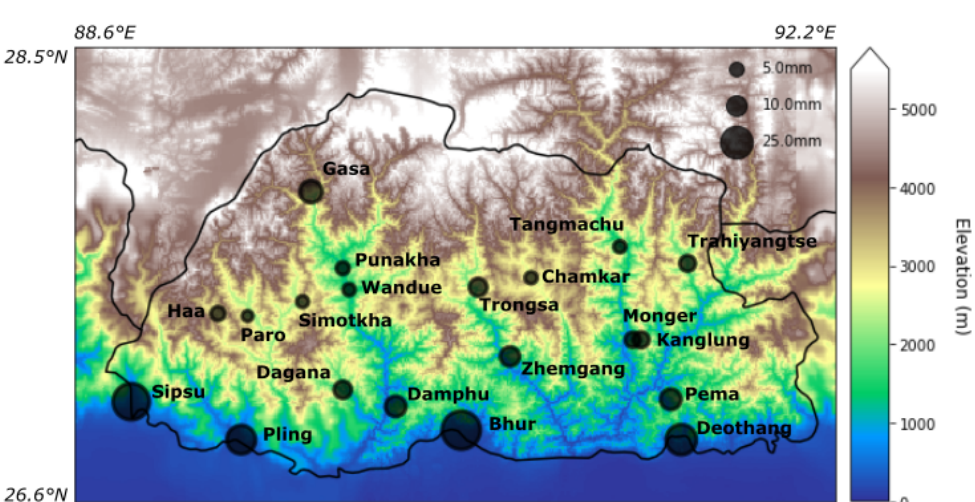
Figure 1. The locations of the 20 weather stations providing the observational monthly precipitation records. Data collection and station management are by the Bhutan Hydrological Department. The size of circle represents the mean daily June to September precipitation data based on 2012 to 2019 records. Data are overlaid on a topographic basemap for the area 79.5° E–92.5° E, 25° N– 30.5° N. Topographic data are sourced from Worldbath ETOPO5 Navy Bathymetry on a 5-minute latitude/longitude grid [24].